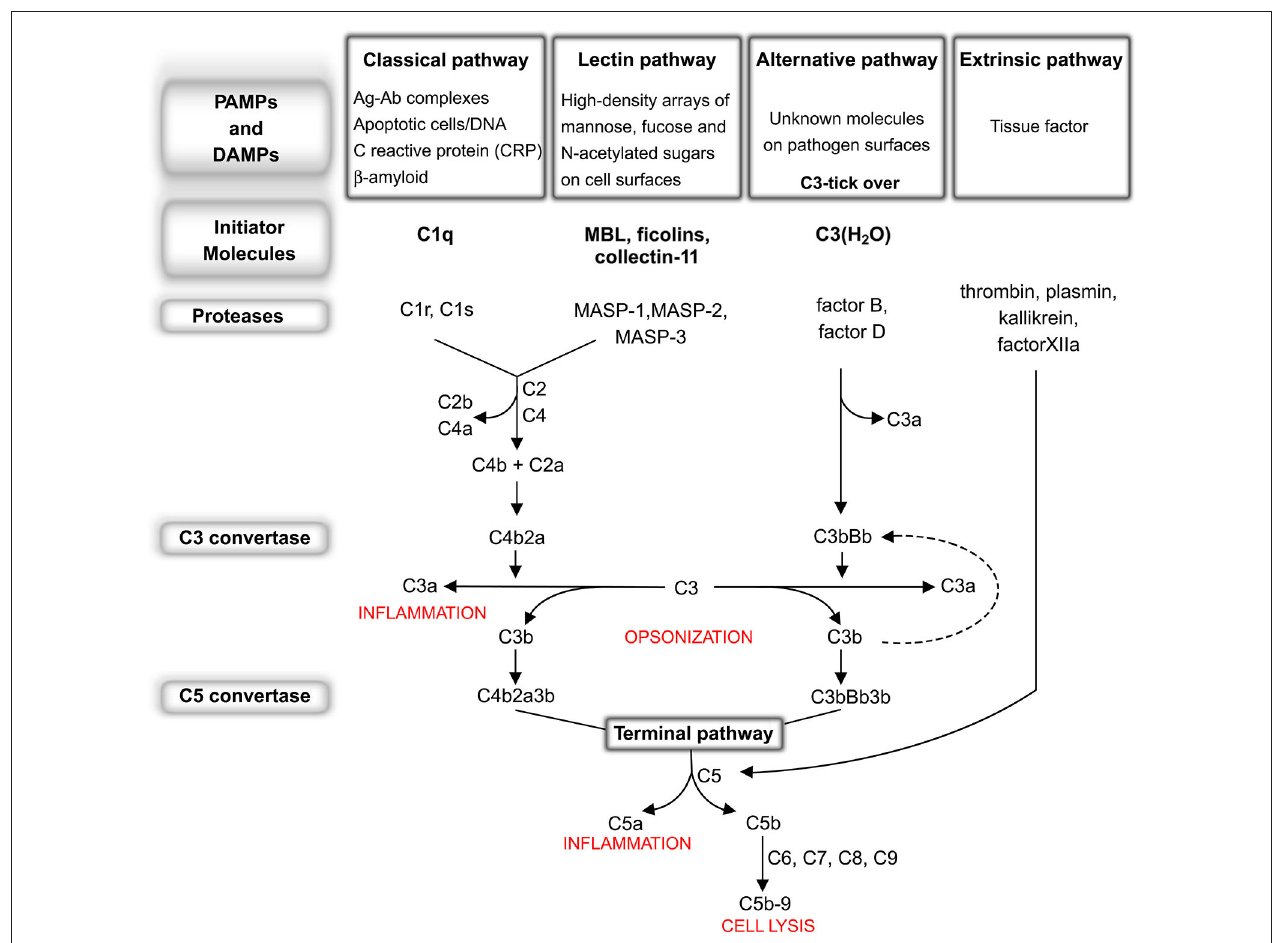
FIGURE 1 | The complement system: an overview. Classical pathway (CP): C1q, the CP initiator, recognizes and binds antigen-antibody complexes or specific molecules, including β -amyloid, C reactive protein (CRP), DNA and apoptotic bodies. After binding, the C1r and C1s proteases subsequently cleave C4 and C2 to generate C4a, C4b, C2a, C2b, permitting the formation of C4b2a (CP C3 convertase). This complex cleaves C3 into C3a, which, in turn, acts as potent anaphylatoxin, and C3b that binds to the complex forming the C4b2a3b protein block (CP C5 convertase). Lectin pathway (LP): MBL, ficolin-1, ficolin-2, ficolin-3 and collectin-11, the LP initiators, recognize and bind high-density arrays of mannose, fucose and N-acetylated sugars exposed by pathogens or by self-altered cells. After binding, the MBL-associated serine proteases (MASPs), MASP-1 and -2, associated in complex with the above recognition molecules (MBL/ficolins), cleave C4 and C2, thereby forming C3 convertase and C5 convertase in a similar manner to that of the CP (Ehrnthaller et al., 2011). The role of the third serine protease, called MASP-3, remains unclear (Kjaer et al., 2013). Alternative pathway (AP): the activation of the AP is driven by a spontaneous hydrolysis of circulating C3 (called tick-over process) to form C3(H 2 O). This molecule then associates factor B and factor D to form C3bBb (AP C3 convertase). Similar to the C3 convertase generated in the CP and LP, this complex splits C3 into C3a and C3b,